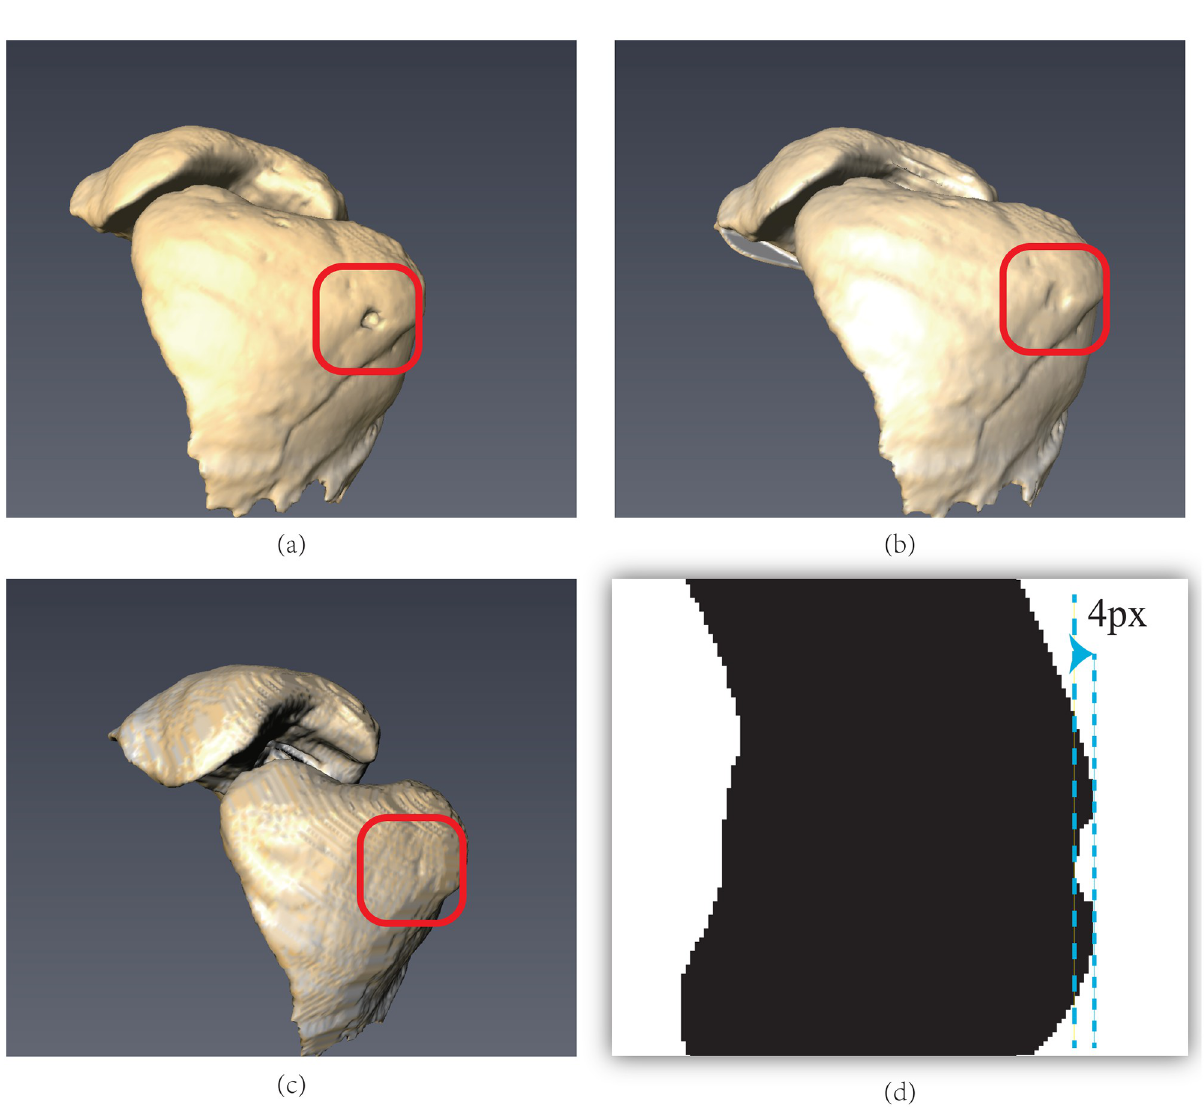
Fig 16. The comparison over 3D reconstruction models. (a) The model based on original CT slices; (b) the 3D model of this manuscript; (c) the reconstruction model of [18]; (d) the error of the algorithm in this paper.